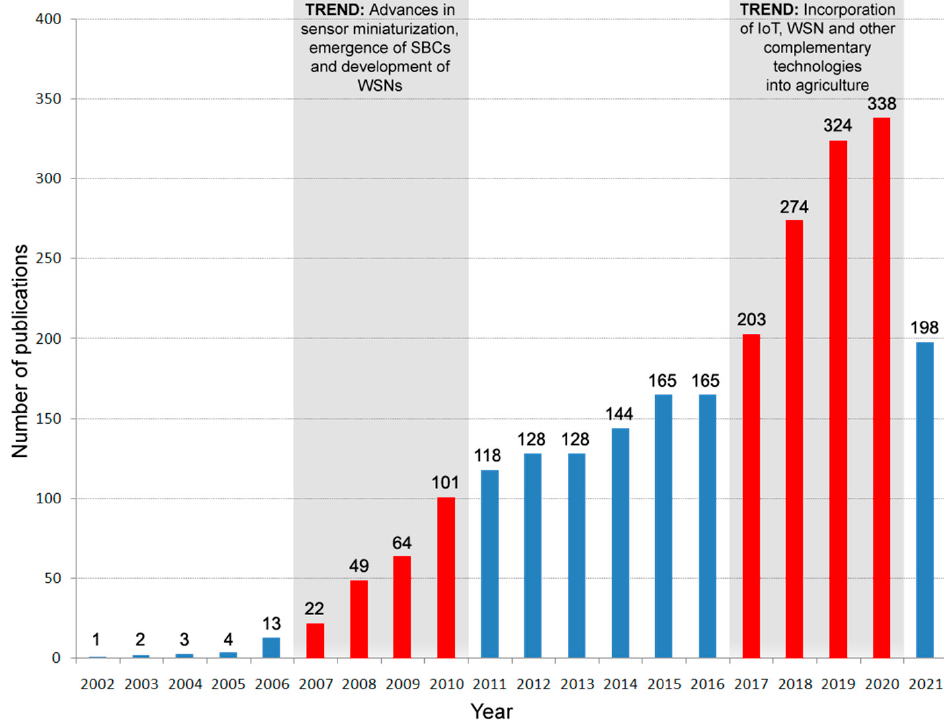
Figure 2. WSN in agriculture, scientific publications per year [11].